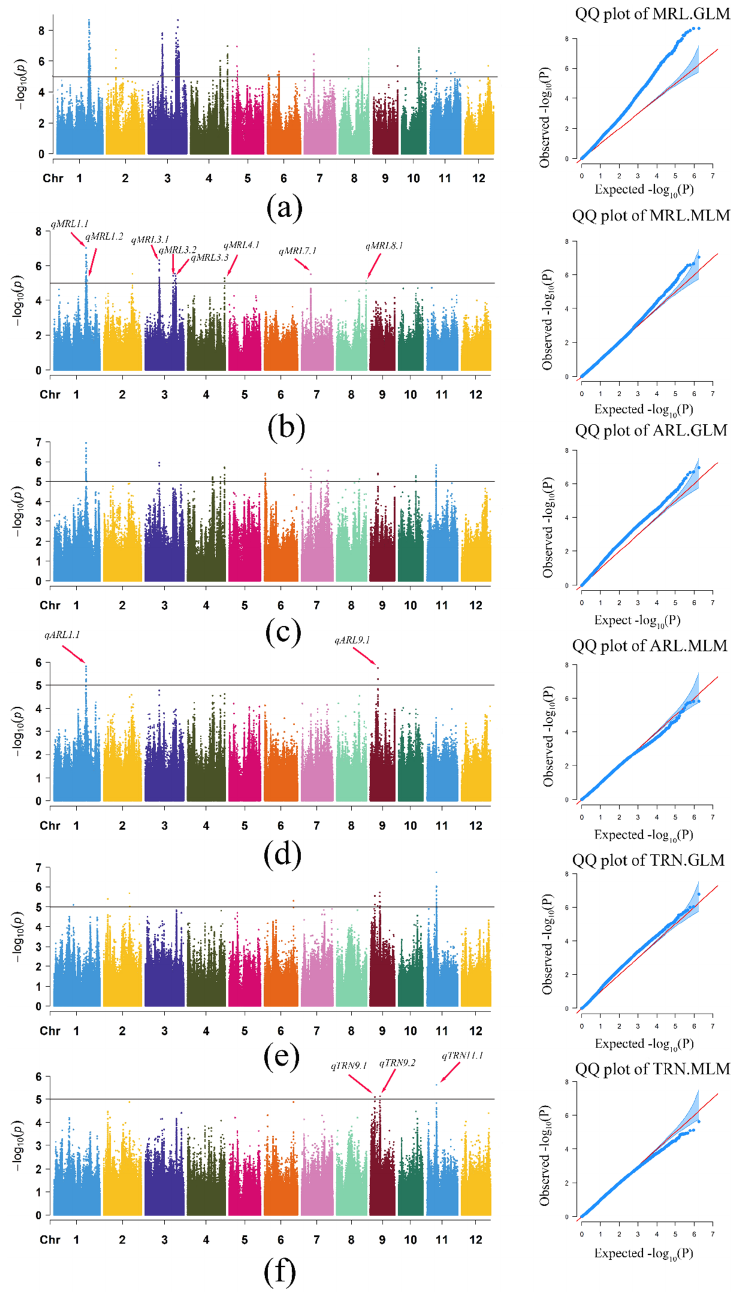
Figure 2. Genome-wide association plots of MRL, ARL, and TRN in rice population plotted using the general linear model and mixed model methods. The Manhattan map of genome-wide scans shows the − log 10 ( p ) values corresponding to the location of each of 12 chromosomes. Black solid lines represent the whole genome significant threshold p = 5.0 × 10 − 5 . Red arrows indicate QTLs ( qMRL1.1 (Chr1_30384232) qMRL1.2 (Chr1_ 31258476) qMRL3.1 (Chr3_13180766) qMRL3.2 (Chr3_26623430) qMRL3.3 (Chr3_28214674) qMRL4.1 (Chr4_34983993) qMRL7.1 (Chr7_9145116) qMRL8.1 (Chr8_27836609) qARL1.1 (Chr1_30377471) qARL9.1 (Chr9_7252407) qTRN9.1 (Chr9_4342978) qTRN9.2 (Chr9_9220591) and qTRN11.1 (Chr11_9292368)) co-localized by GLM and MLM. The horizontal axis in the quantile-quantile (QQ) plot represents the expected value of the − log 10 transformation, whereas the vertical axis represents the observed value of the − log 10 transformation. Manhattan plot and QQ plot of MRL ( a ) in GLM ( b ) and MLM; Manhattan plot and QQ plot of ARL in GLM ( c ) and MLM ( d ); Manhattan plot and QQ plot of TRN in GLM ( e ) and MLM ( f